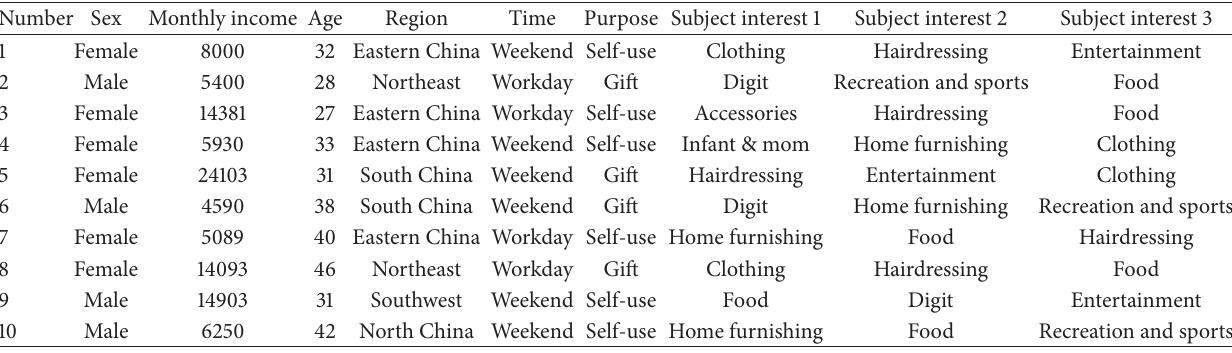
Table 1: Users’ contexts and interest rules table (part of C5.0 rules).